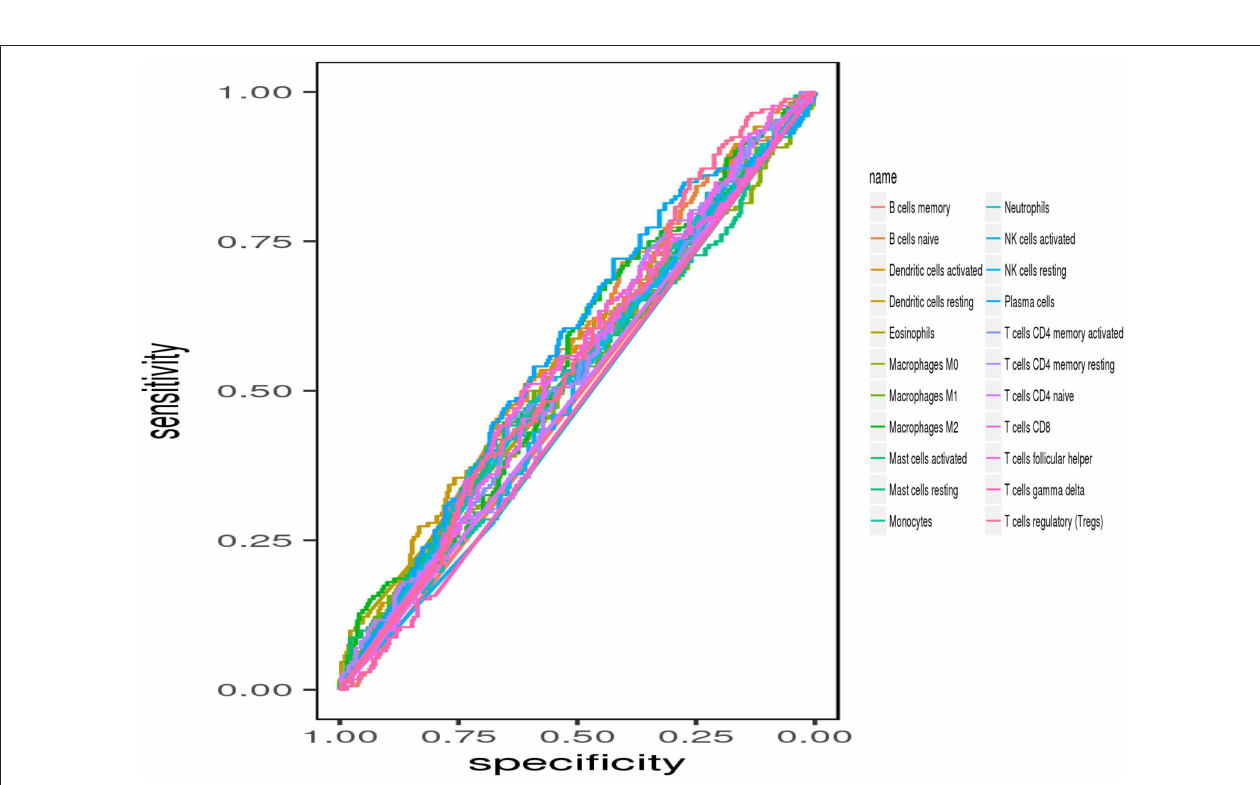
FIGURE 8 | ROC curves of prognostic predictors built by the 22 immune cell subsets.